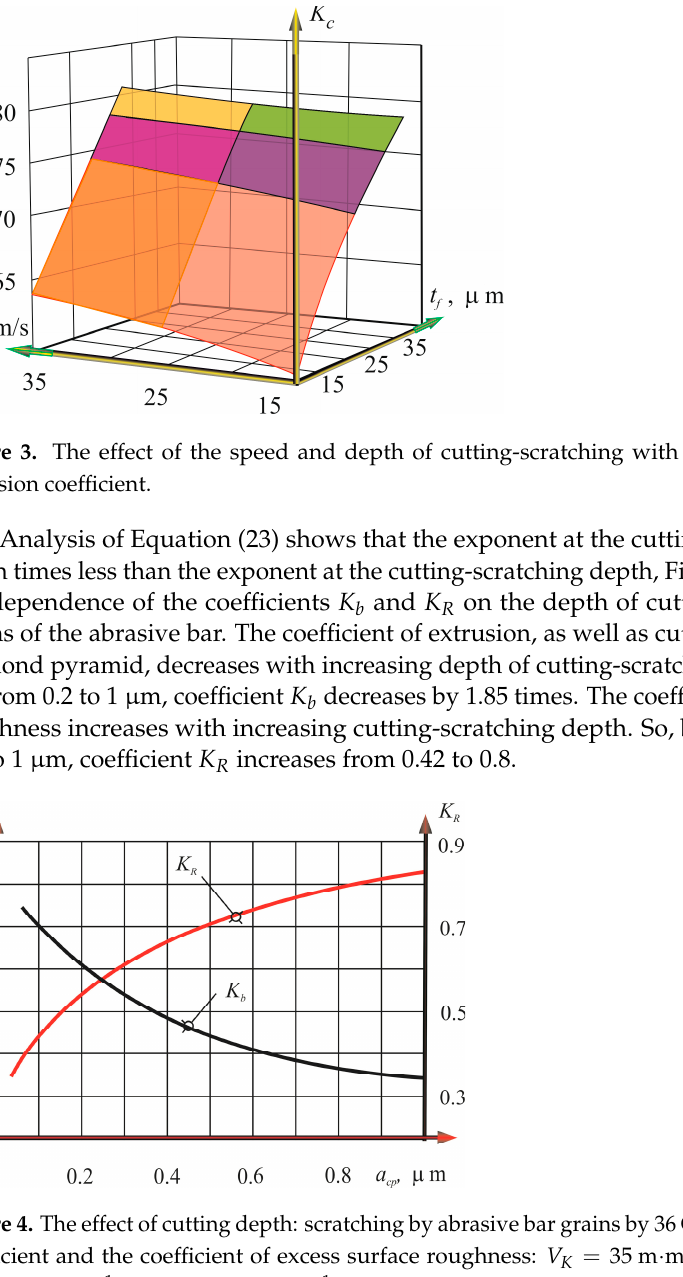
Figure 4. The effect of cutting depth: scratching by abrasive bar grains by 36 CM BB П on the extru- sion coefficient and the coefficient of excess surface roughness: 𝑉 𝐾 = 35 m · min −1 ; 𝑉 𝑤 = 20 m · min −1 ; 𝑆 = 1.0 m · min (cid:2879)(cid:2869) ; 𝑡 = 0.05 mm · unit −1 . 𝑥